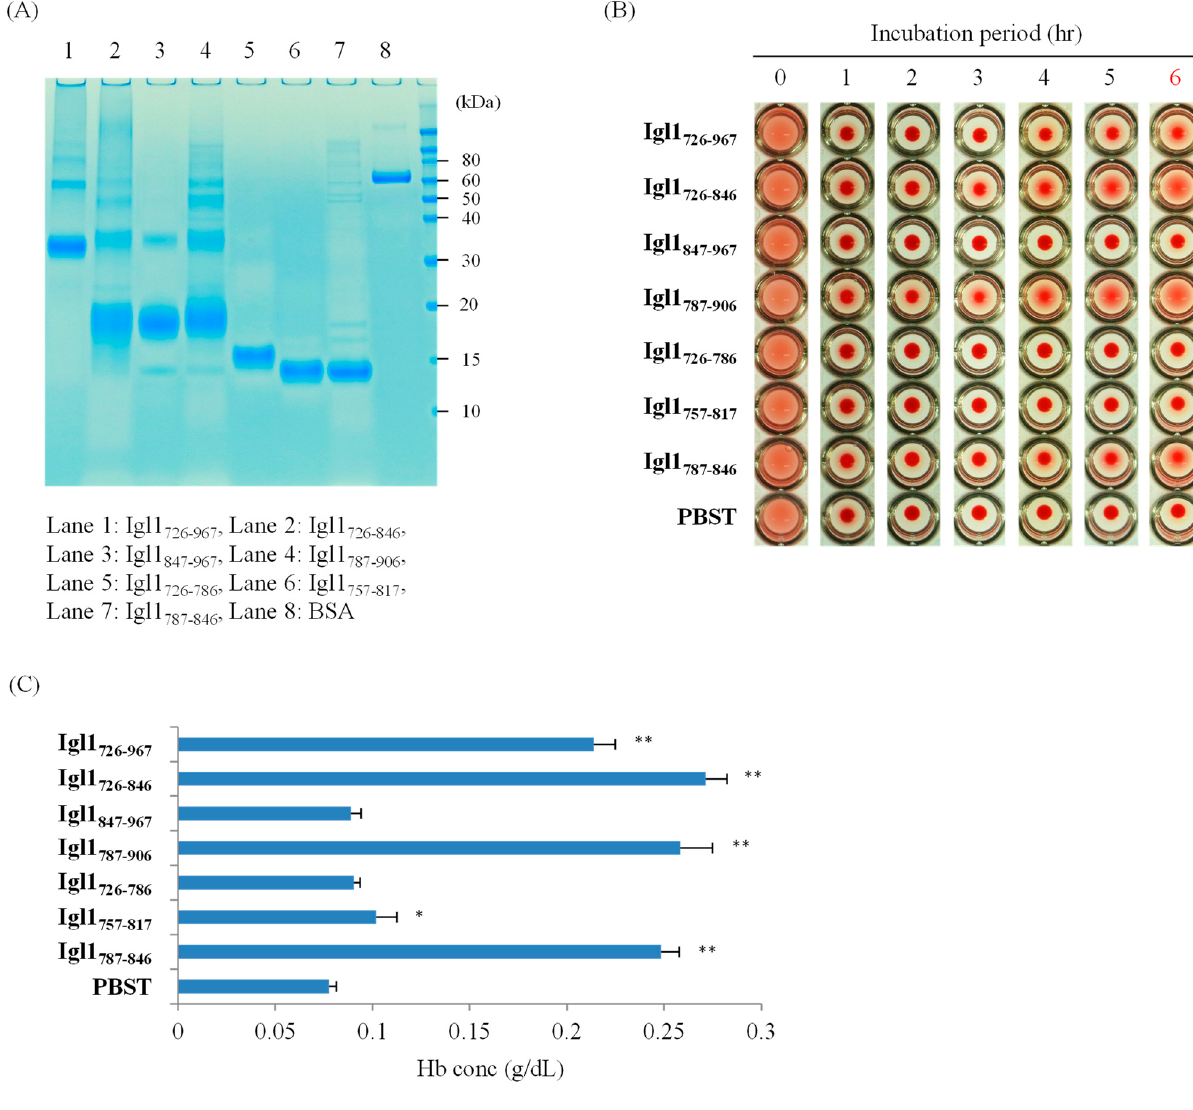
Figure 1. Hemolytic activity of recombinant Igl1 fragment proteins based on Igl1 726-967 . ( A ) Purities and amounts of recombinant proteins were confirmed by SDS-PAGE, with 1 μ g of each protein run on the gels. ( B ) HoRBCs were incubated in a 96-well plate with Igl1 fragment proteins for the indi- cated periods. Representative images of 5 independent studies are shown. ( C ) Concentrations of